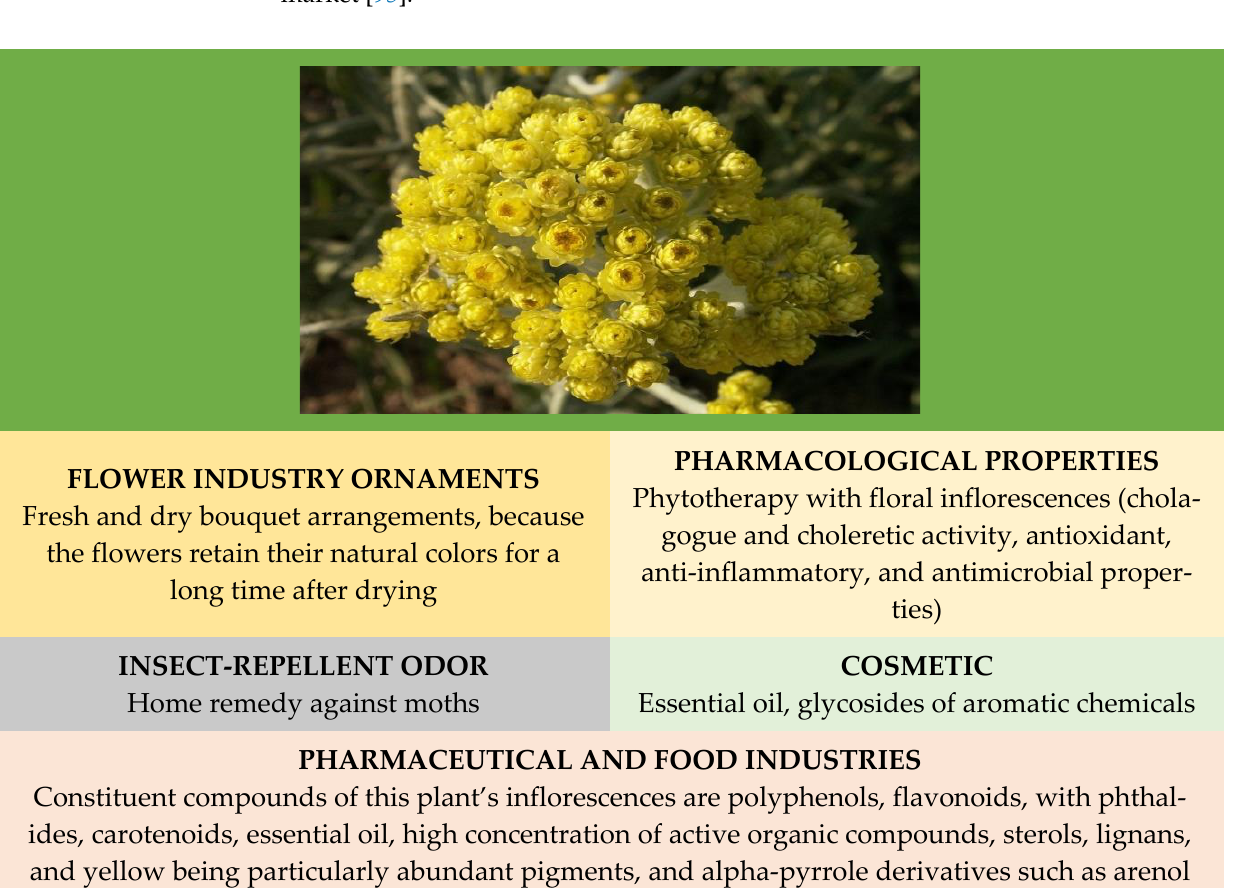
Figure 4. Pharmacoeconomic benefits of Helichrysum arenarium (L.) Moench.